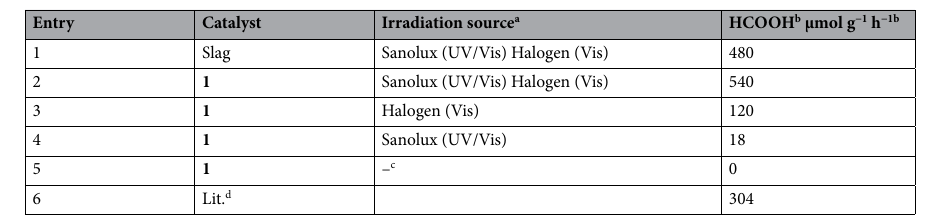
Table 1. CO 2 photoreduction reactions catalysed by 1. General reaction conditions: 30 mg of catalysts in water suspension volume = 20 mL, T = 25 °C, irradiation time = 5 h (see experimental section). a The characteristics of irradiation source were reported in supporting information. b Yields of formic acid were determined by a calibration curve (see supporting information Fig. S10). c Without irradiation (blank reaction). d Eu-MOF as catalyst 5